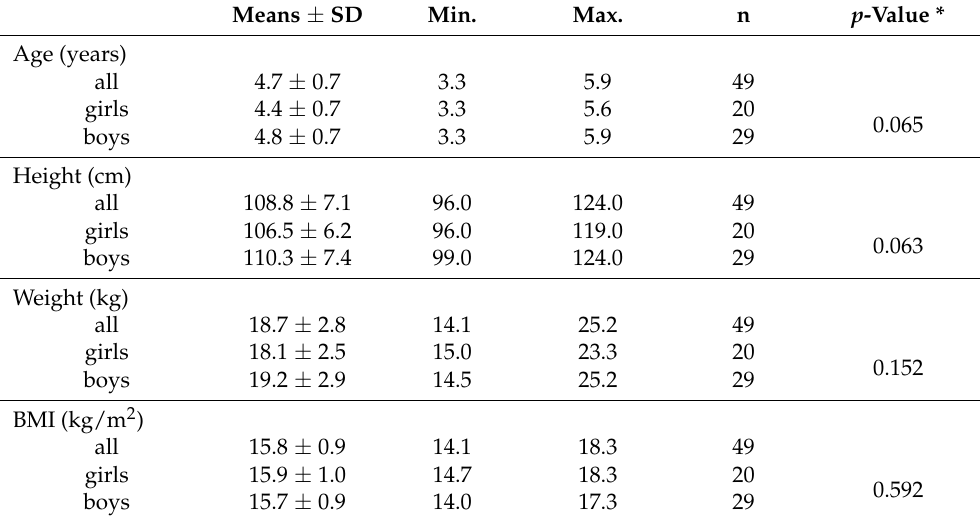
Table 1. Anthropometric data overall and separated by